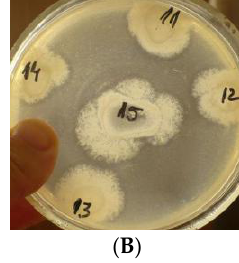
Figure 7. Catalase production: ( A ) B. mycoides (Bm) insignificant; ( B ) P. putida (B1) positive .